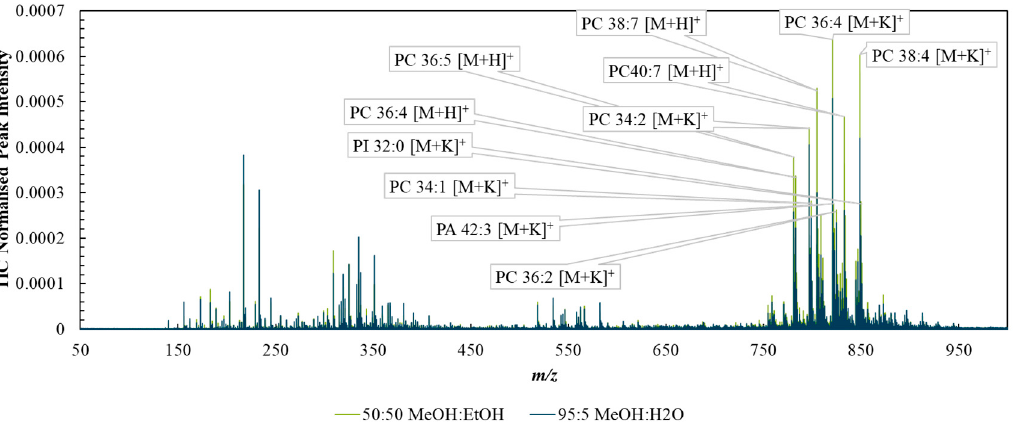
Figure 2. Spectra taken from regions of interest capturing tissue-only areas acquired with DESI using the two solvent systems—95:5 (% v/v ) methanol/water (blue) or 50:50 (% v/v ) methanol/ethanol (green).